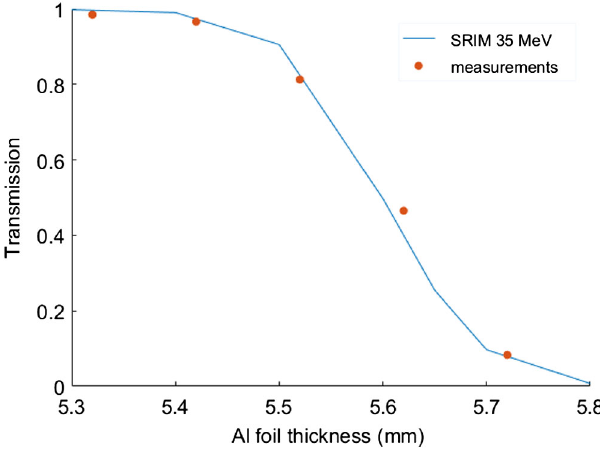
FIG. 17. Beam current transmission in aluminum: Experimen- tal data and computed curve for 35 MeV protons.